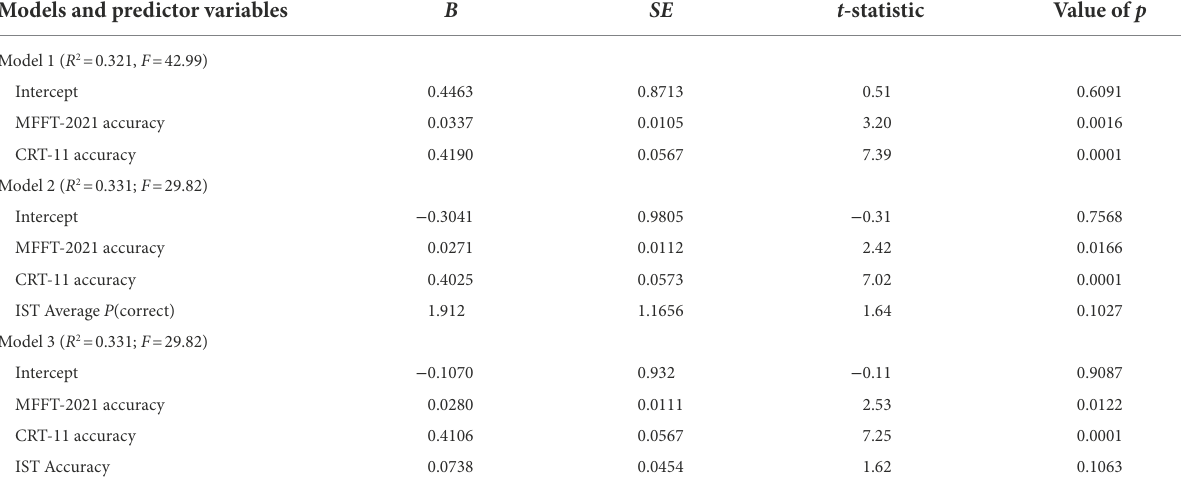
TABLE 8 Study 2 Regression analysis of heuristics-and-biases composite. Models and predictor